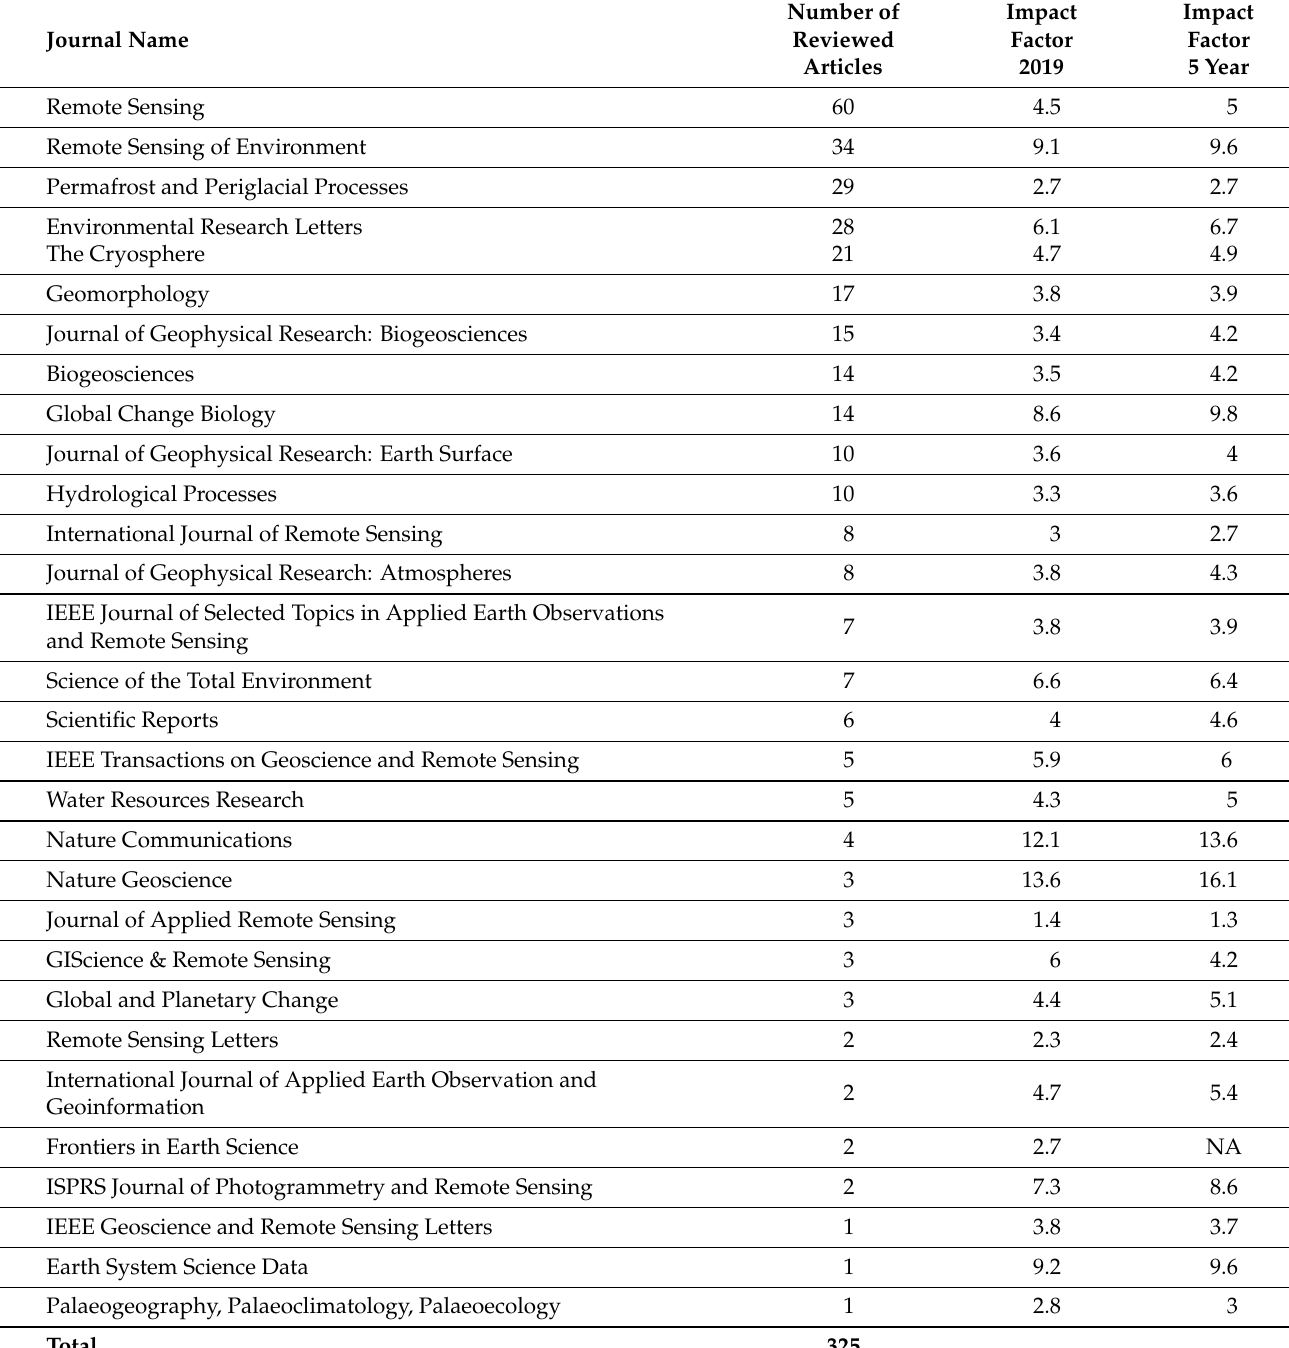
Table 3. List of reviewed journals, the number of articles per journal covered in this review and their respective impact factor for the year 2019 as well as the 5-year impact factor according the Web of Science [143] (rounded to the first decimal